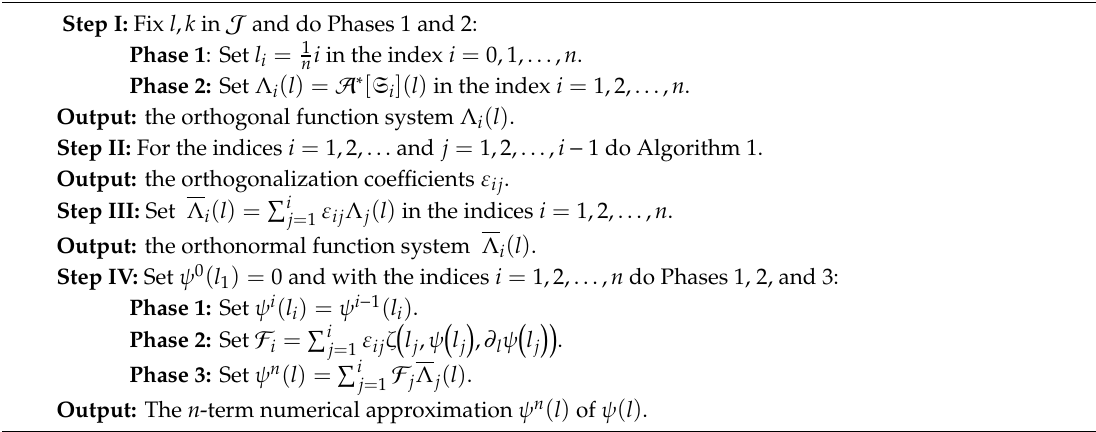
Algorithm 2. Steps of RKDM for numerical approximations model of FLETM in ABC